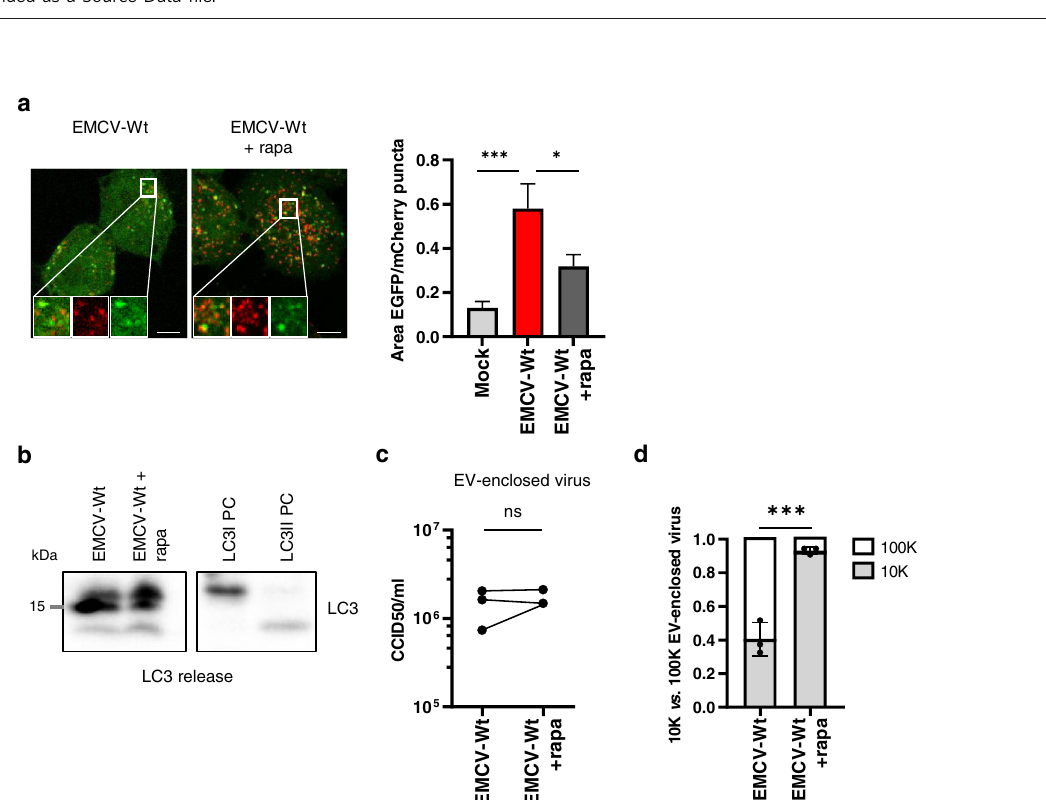
Fig. 4 The EMCV Leader promotes the accumulation of autophagosomes during infection. a Mock-infected cells and cells infected with EMCV-Wt or EMCV-L Zn were harvested 8h p.i. Whole-cell lysates were analyzed for conversion of LC3I to LC3II by western blotting and the LC3II:LC3I ratios were calculated relative to mock-infected cells. *Indicates a detected LC3 band with intermediate size. Actin was included as a loading control and EMCV-3D to con fi rm infection. Depicted are representative blots and the mean±SD of n = 4 independent experiments. * p = 0.0341 (bottom), p = 0.0257 (top) as determined by a two-tailed one-sample t -test. # p = 0.0437 using a two-tailed t -test. b Schematic overview of the mCherry-EGFP-LC3 autophagy reporter system. Using spot detection on LC3 reporter cells imaged by confocal microscopy, the accumulation of LC3 in autophagosomal vs. autolysosomal compartments can be monitored. Whereas autophagosomes appear as mCherry + EGFP + LC3 + puncta, autolysosomes are detected as mCherry + EGFP − LC3 + puncta due to a loss of EGFP fl uorescence in the acidic environment of the autolysosome lumen. c LC3 reporter cells were infected with EMCV-Wt or EMCV-L Zn for the indicated time or treated with bafA1 for 6h and imaged for EGFP and mCherry fl uorescence using confocal microscopy. Some EGFP + compartments seem to lack mCherry signal, but this is likely due to the lower detection ef fi ciency of mCherry versus EGFP. Bar graphs display a quanti fi cation of the ratio between the total surface area of EGFP and mCherry positive puncta as a measure for the ratio between the autophagosomes and autolysosomes present in the cells. Indicated are mean values±SEM of ≥ 7 separate images with 2 – 5 cells each from a representative of n = 3 individual experiments. ** p = 0.0083, *** p = 0.0001, **** p <0.0001 as assessed by one-way ANOVA with Dunnett ’ s multiple comparison test. Scale bar = 20 µ m. ( d ) Infected cells were stained with 50nM lysotracker and compared to mock-infected cells or bafA1 treated controls 6h p.i. using live-cell confocal imaging. Depicted are representative images showing lysotracker fl uorescence staining. Bar graphs display the average cellular staining intensity relative to uninfected controls. Indicated are mean values±SD of fi ve independent experiments. Scale bar = 30 µ m. ** p = 0.0012, as assessed by a one-sample t -test. ns, p = 0.1400 as assessed by an unpaired, two-tailed t -test. Source data are provided as a Source Data fi le.